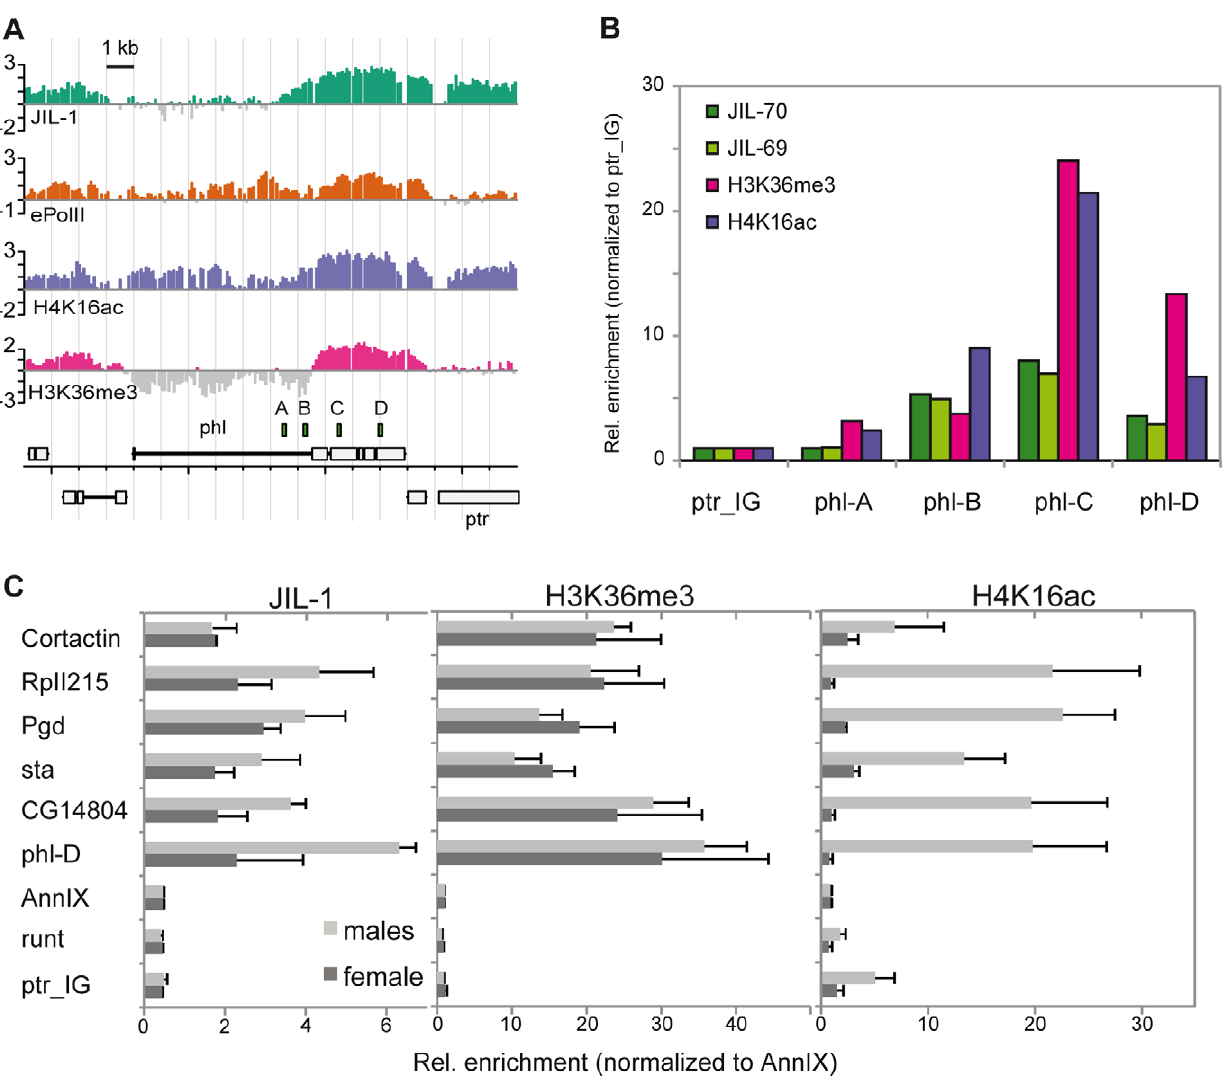
Figure 2. JIL-1 is enriched at the 3 9 end of phl and is twofold enriched at X-linked loci in male flies. Comparison of the distribution of JIL- 1, ePol, H4K16ac and H3K36me3 on the X-linked gene phl in SL2 cells. (A) Signals as revealed by ChIP-chip profiling were compared to (B) the qPCR- based quantification of unamplified material. The position of the amplicons used for qPCR is indicated above the gene annotations. The relative enrichments from amplicons A to D were calculated using the intergenic region located , 2 kb left of the gene ptr (ptr_IG) as a reference. (C) Comparison of the enrichment of JIL-1, H3K36me3 and H4K16ac at the 3 9 end of the active X-linked genes phl , CG14804, sta, Pgd, RpII215 and of the active autosomal gene Cortactin . The inactive X-linked gene runt , the promoter region of the annexin IX gene flanking the Cortactin gene and the intergenic region close to ptr served as negative control regions. Signals were normalized to the annexin IX locus and error bars represent the standard error of the mean for 3 independent biological